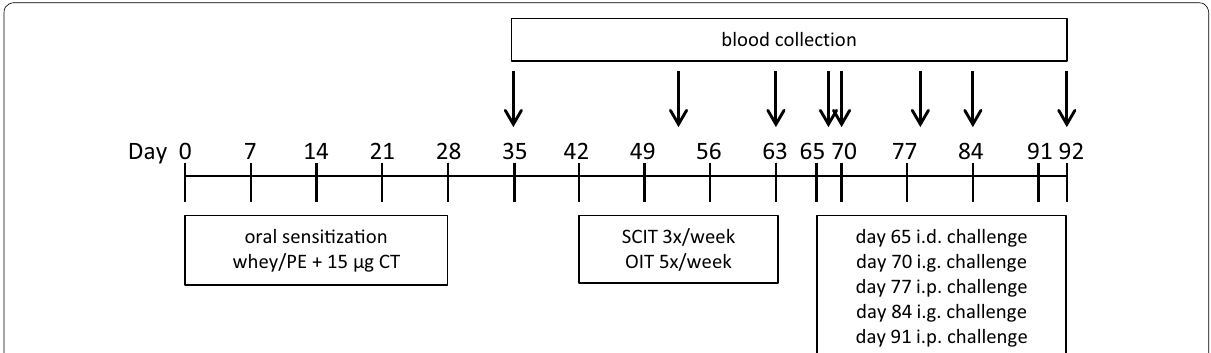
Fig. 1 Experimental set-up of PNA and CMA model. Mice were sensitized i.g. to whey, PE or PBS alone in combination with CT (day 0, 7, 14, 21 and 28 for CMA and day 0, 1, 2, 7, 14, 21 and 28 for PNA). From day 42, the mice were treated orally for 5 times/week or subcutaneously for 3 times/week with allergen or PBS alone, for three consecutive weeks (day 42–60). On day 65, all mice were challenged i.d. to determine the acute allergic skin response, anaphylactic shock symptom scores and body temperature levels. On day 70 and 84, i.g. challenges were performed to measure mucosal mast cell degranulation. After i.p. challenges on day 77 and 91, anaphylactic shock symptom scores and body temperature levels were measured. At day 92, the mice were killed with cervical dislocation and blood and organs were collected. PE peanut extract, CT cholera toxin, SCIT